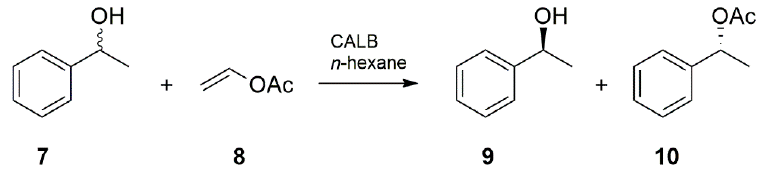
Figure 6. Kinetic resolution of ( R,S )-1-phenylethanol catalyzed by Candida antarctica B lipase. The results of transesterification catalyzed by CALB immobilized on powders with various linker chain length are presented in Table 3. Table 3. Enzyme load and results of transesterification of ( R,S )-1-phenylethanol with vinyl acetate catalyzed by CALB immobilized on modified powders. Enzyme immobilization strategy—covalent bonding—C 4 H 8 NH 2 + E, C 10 H 20 NH 2 + E, C 10 H 20 O 2 NH 2 +E; physical adsorption—C 4 H 9 + E. Powder